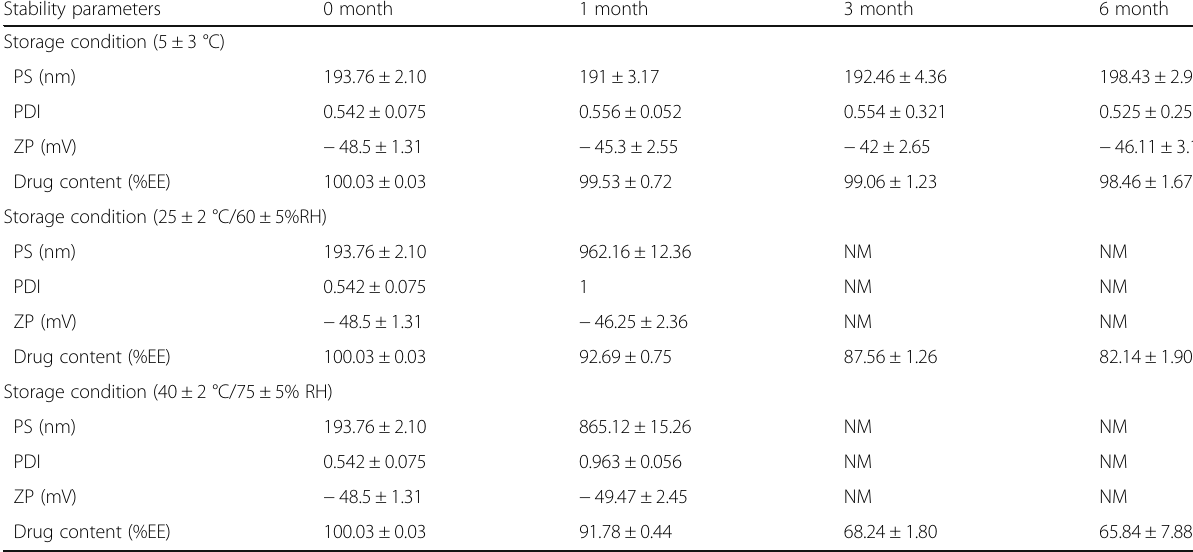
Table 6 Stability profile of lyophilized HVD-NLCs (VER-9) in terms of PS, PDI, ZP, and drug content ( n = 3) in different storage